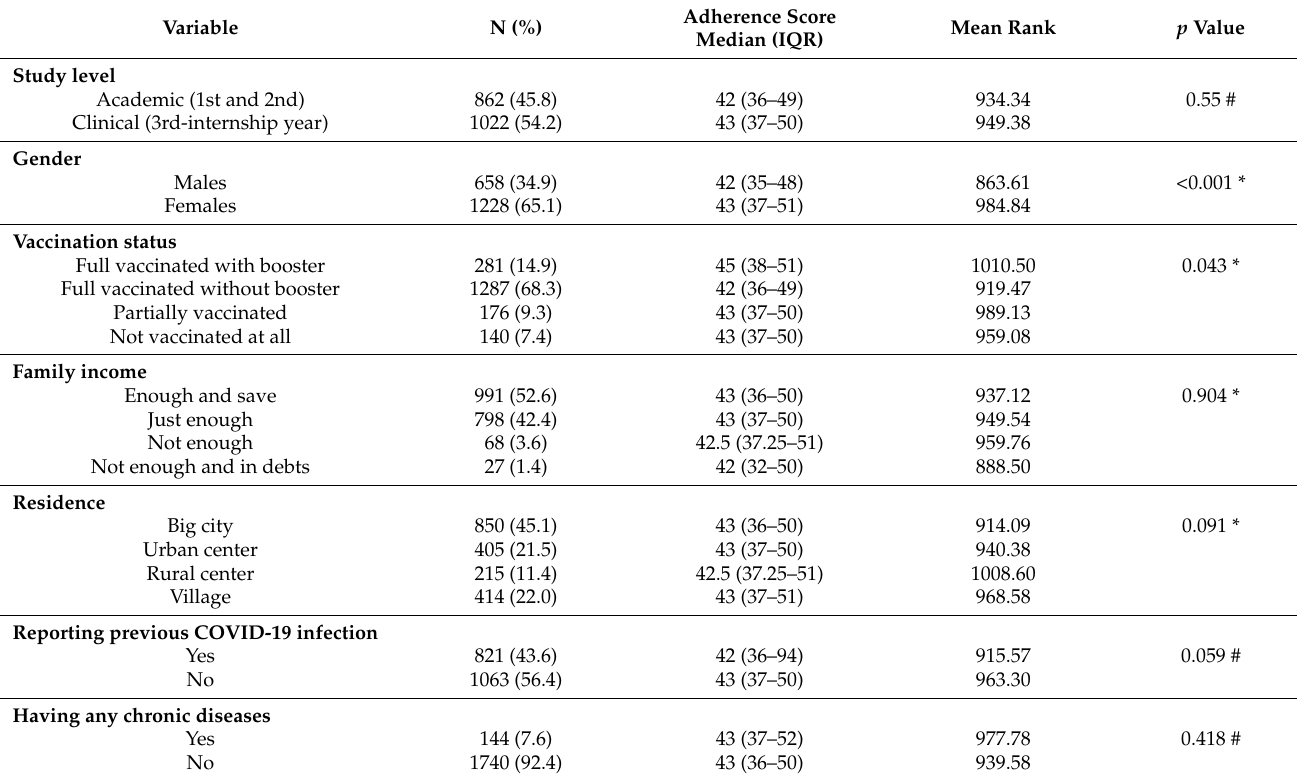
Table 1. Sociodemographic profiles and analysis of protective behaviors following